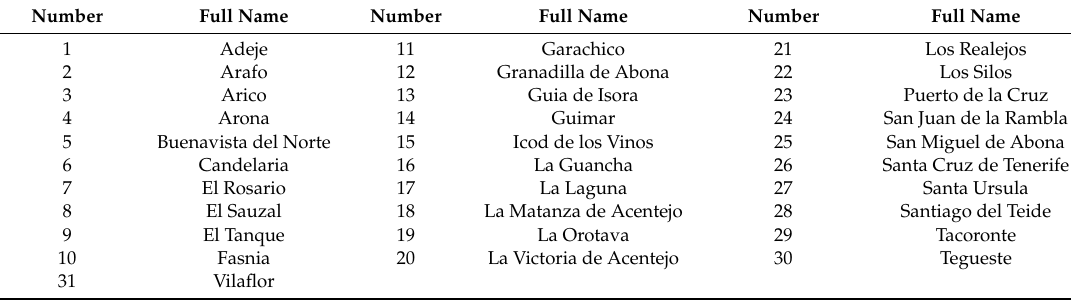
Table 1. Municipalities of Tenerife. The number labels are used consistently to represent their respective municipalities in the figures of this article.